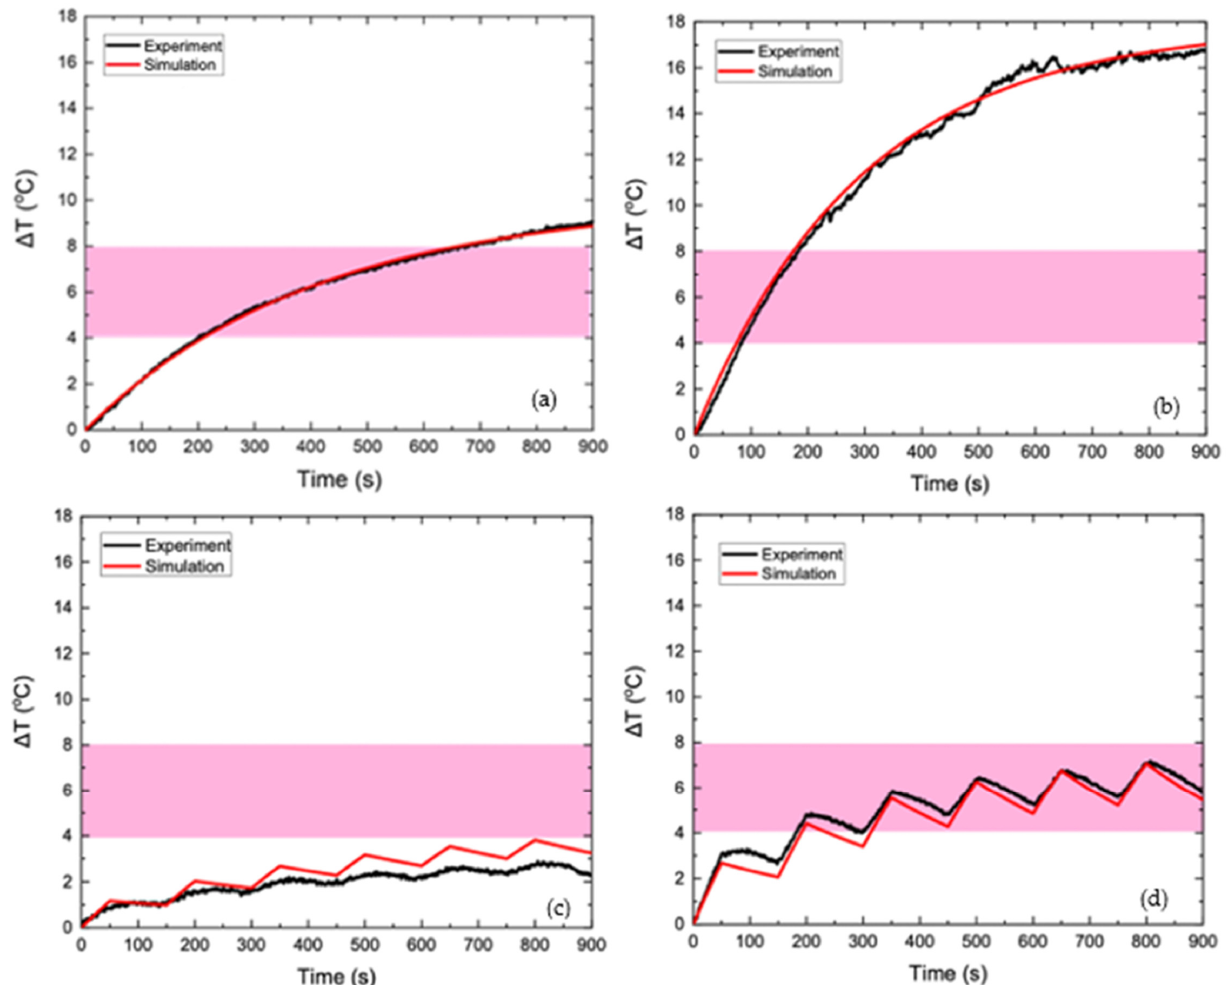
Figure 11. Temperature increase with time of HTP sample under 45 mT of continuously applied AMF ( a ) and 45 mT of PMF ( c ) and temperature increase with time of CTP sample under 45 mT of continuously applied AMF ( b ) and 45 mT of PMF ( d ). In all the Figures the experimental data correspond to the black colored curves, while the numerical data correspond to the red colored curves. In the HTP sample, the observed temperature increase is attributed solely to eddy currents, since this phantom did not contain MNPs. Figure 11a shows that the numerical heating curve approached the experimental data with great accuracy, which proves the validity of the model in the context of heating a phantom with eddy currents. In Figure 11b, good agreement between the simulation and experiment is also observed for the CTP sample, where heating is generated by both eddy currents and MNPs losses. As shown in Figure 11c,d, which refer to the temperature increase of the HTP and CTP samples, re- spectively, the values of Δ Τ ( t ) in the experimental process have a non-linear response to field shifts—from switched on to off and vice versa. This behavior is probably, due to the uncertainties introduced by the experimental measurement process. The measurement of the temperature through the optical fiber is performed under non-adiabatic conditions, since there is a heat exchange between the sample and the environment. The position, where the fiber is placed will affect the final result of the measurement [30]. Also, the response of the fiber to the change in temperature is not instantaneous [31] and deviates